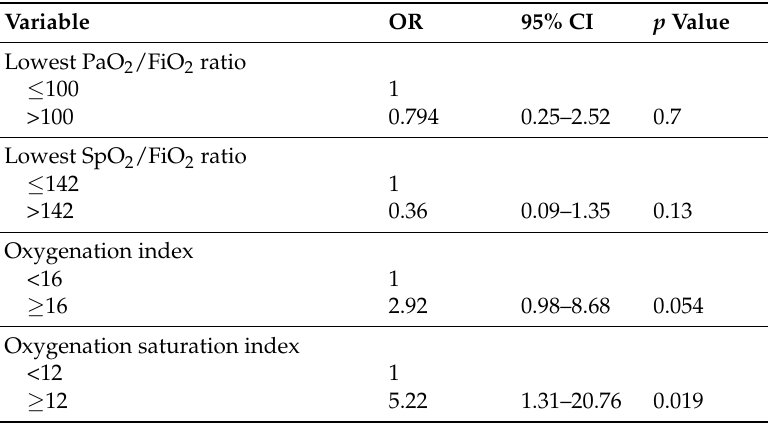
Table 3. Risk factor of in-ICU